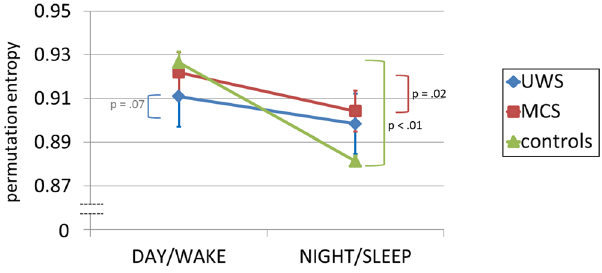
Figure 6. EEG complexity change from day to night averaged across the whole brain. Note that signal complexity decreases significantly from day to night in control and MCS patients. In UWS patients we could observe a trend towards a significant change. Abbreviations: PE = Permutation Entropy, UWS = Unresponsive Wakefulness Syndrome, MCS = Minimally Conscious